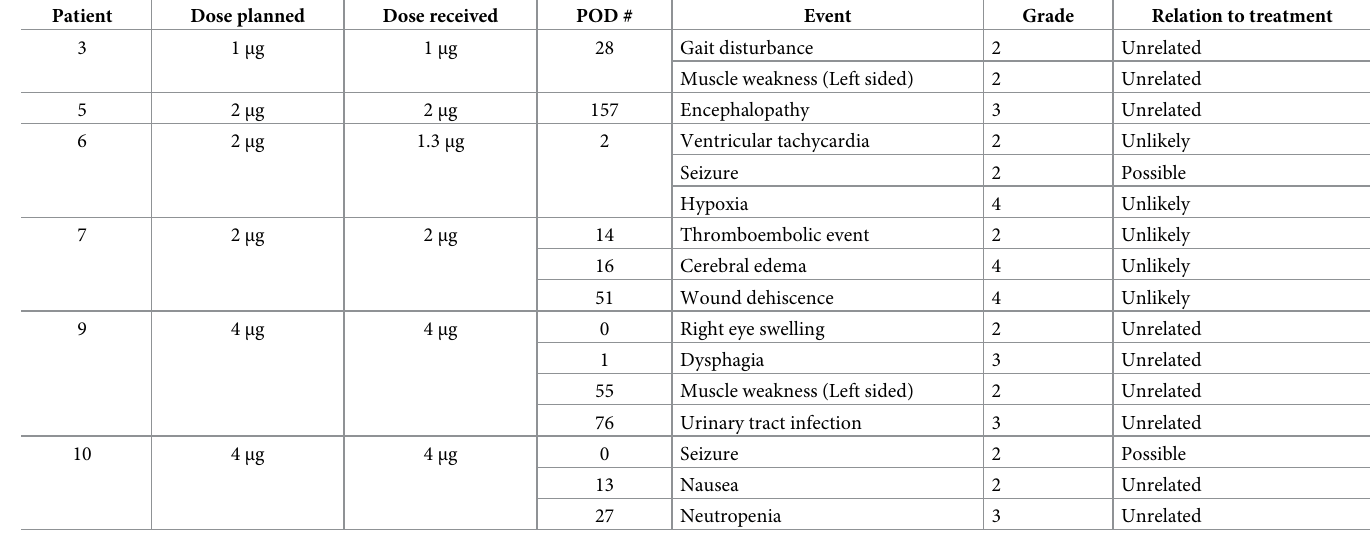
Table 4. Reported adverse events (grade �